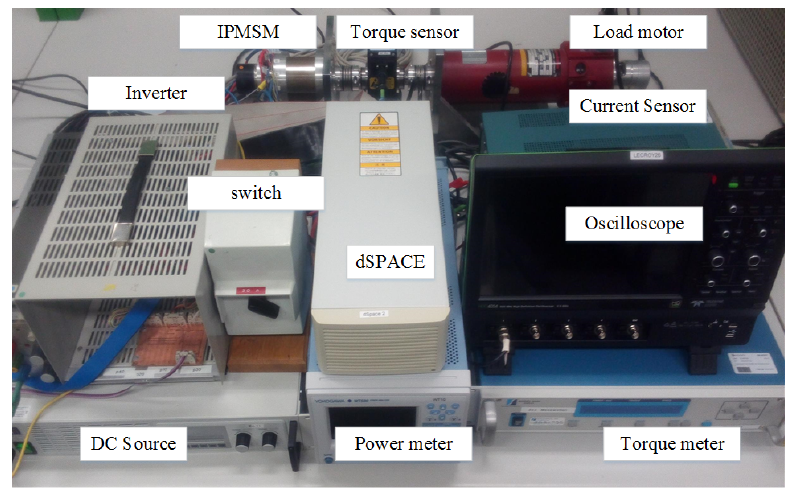
Figure 5. The test bench. Table 1. Parameters of the tested IPMSM.